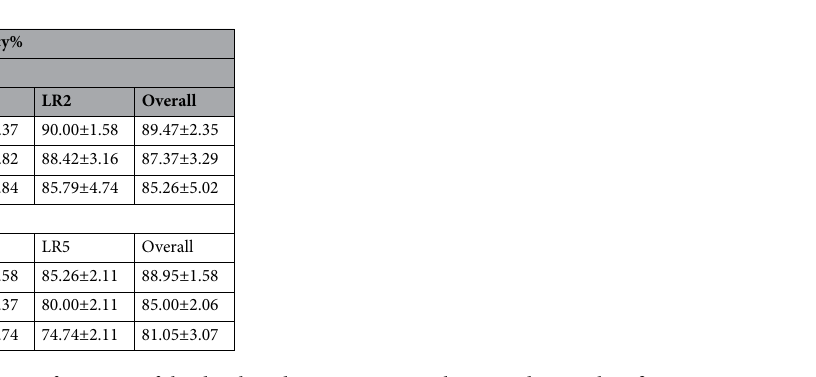
Table 6. Diagnostic Performance of the developed CAD system in the second stage classification: LR1 vs. LR2 and LR4 vs. LR5 using RFs classifier utilizing the combined markers.